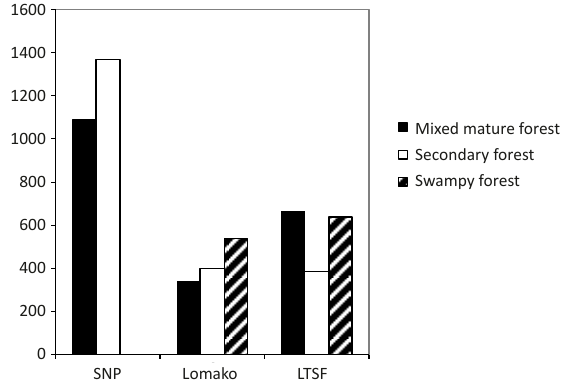
Figure 2 Mean tree density (trees/ha) per forest type at LTSF, SNP and Lomako (Boubli et al . 2004).